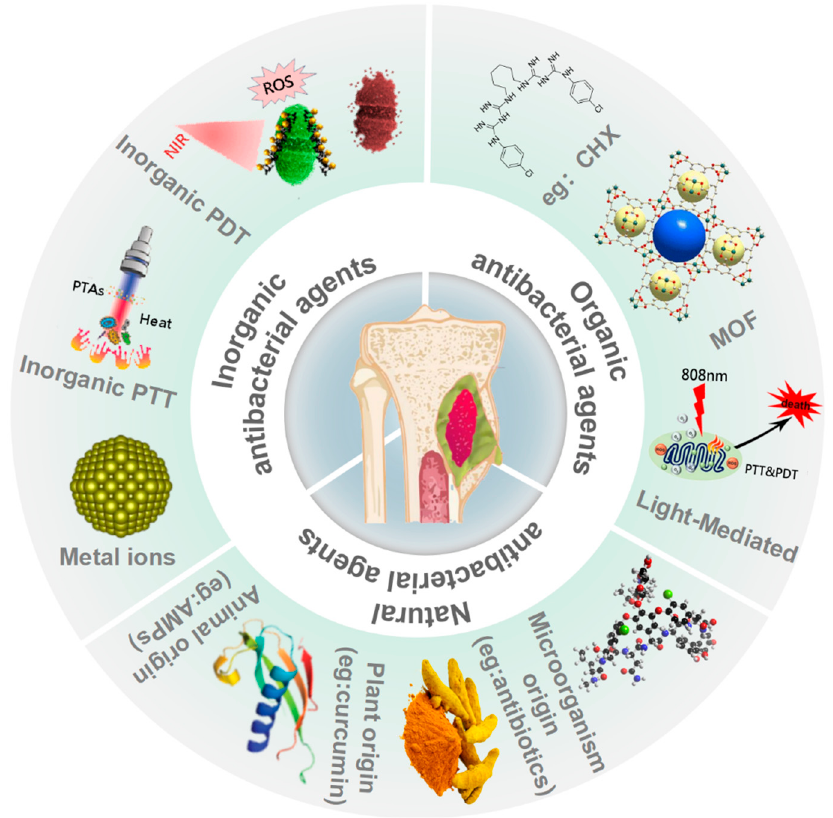
Figure 1. Antibacterial agents and their categories for infected bone defects.